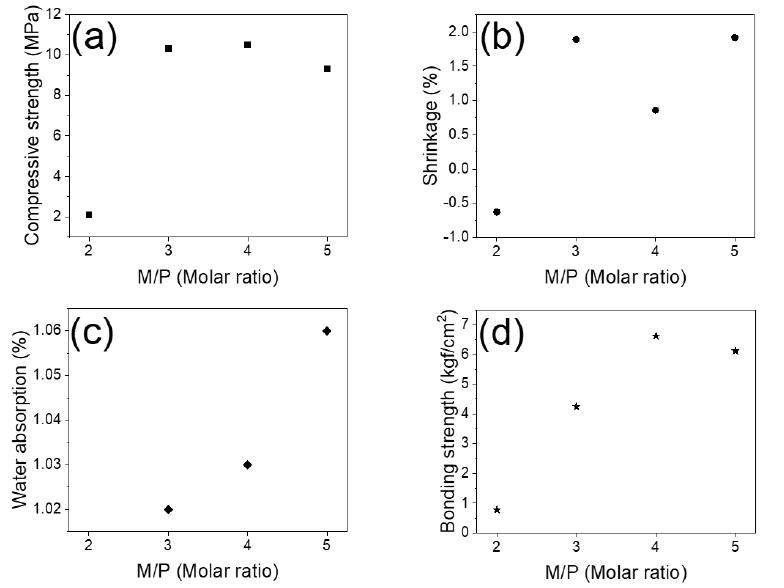
Figure 2. The properties of ( a ) compressive strength, ( b ) volume shrinkage, ( c ) water absorption, and ( d ) bonding strength of MgKPO 4 · 6H 2 O at different magnesia/KH 2 PO 4 molar ratios after a three-hour hydration reaction in the atmosphere.